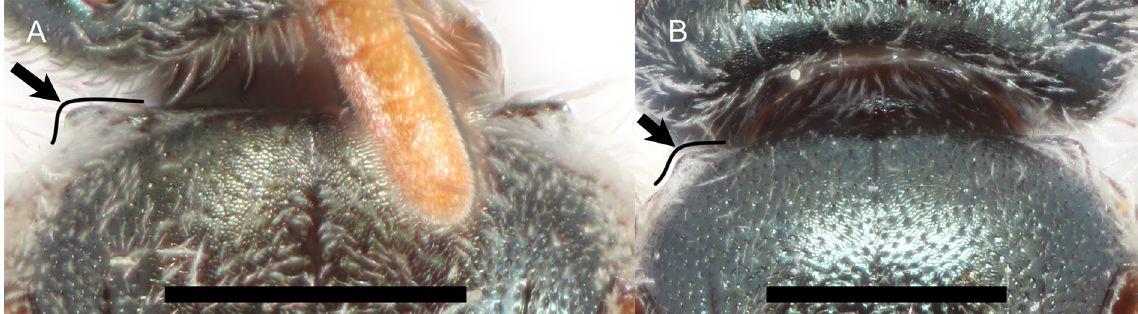
Fig. 107. Pronotal angle (arrow and outline). A . Lasioglossum ( D. ) hudsoniellum (Cockerell, 1919), ♀, nearly 90 degrees. B . L. ( D. ) minckleyi sp. nov., ♀, obtuse. Scale bars: 0.5 mm.